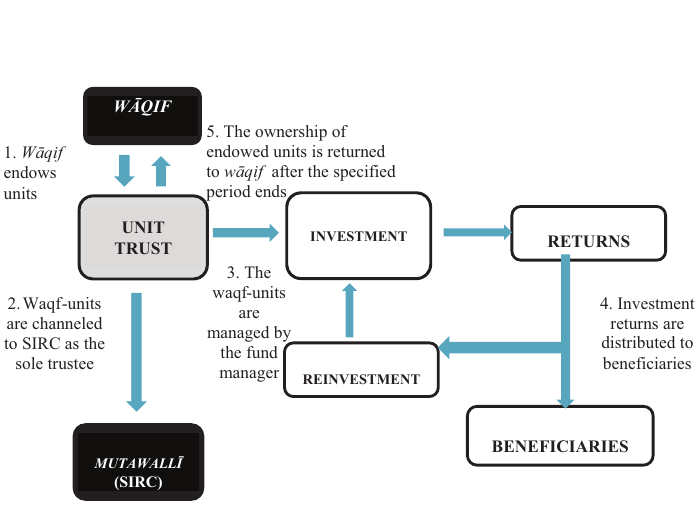
Figure 2. First proposed model: unit trust